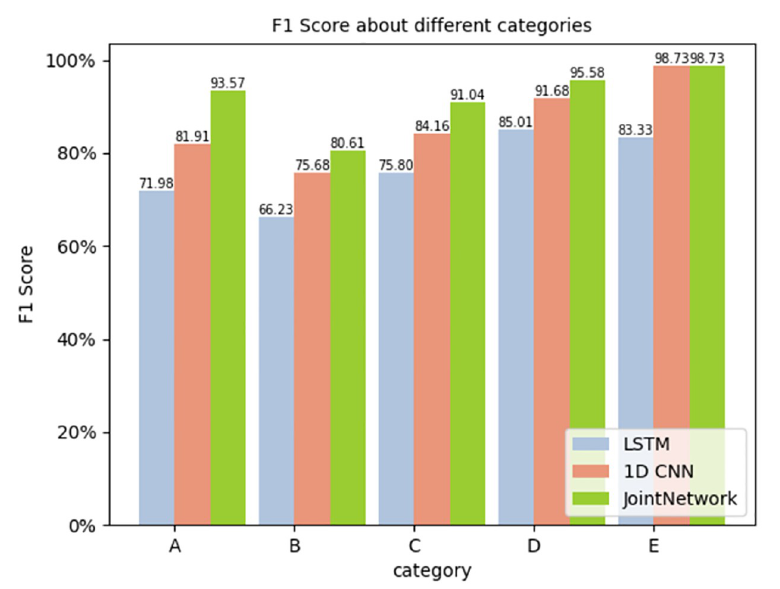
Fig 11. F1 Score about different